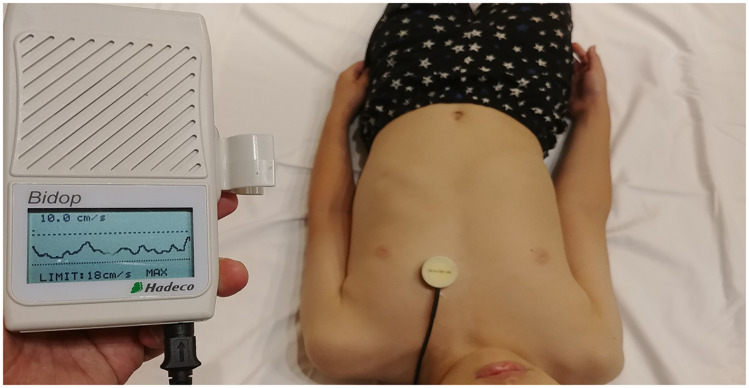
Image of the precordial Doppler machine that was attached to the anterior chest of the subject.The precordial Doppler probe was attached either on the third, fourth, fifth, or sixth intercostal space along the right or left parasternal border where the Doppler sound was most audible.